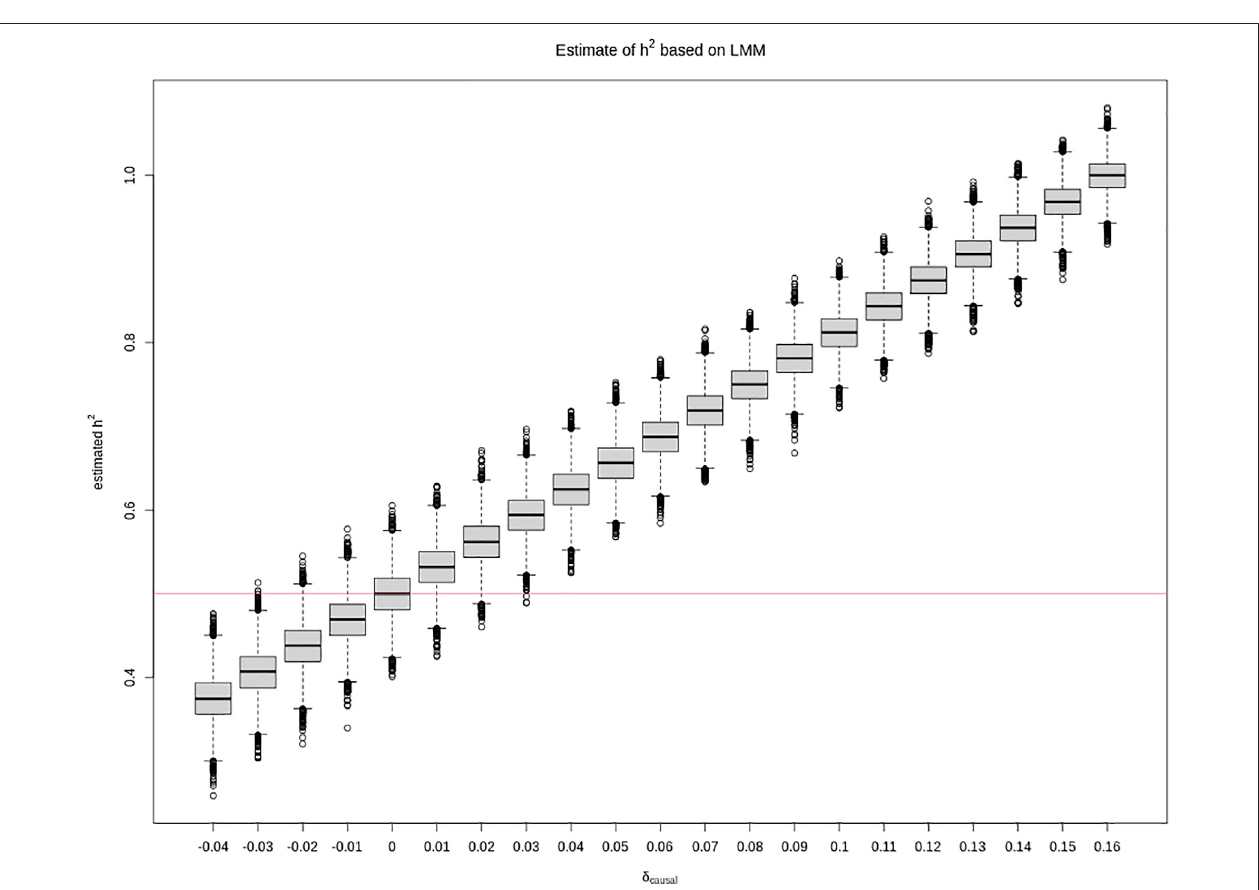
FIGURE 2 | Box plots of ^ h 2 , estimated from the linear mixed-effect model ( Eq. 4 ) against δ causal using 5,000 sibling pairs. The other parameter values are the same as in Figure 1 , where the true heritability of the phenotype is h 2 = 0.5, the minor allele frequencies p causal = p tested = 0.2, and 10,000 independent replicates were simulated for each δ causal